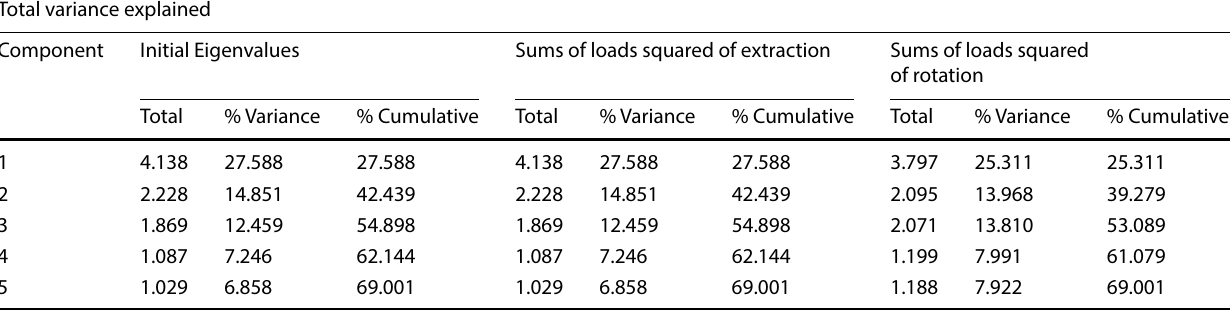
Method of extraction: Principal